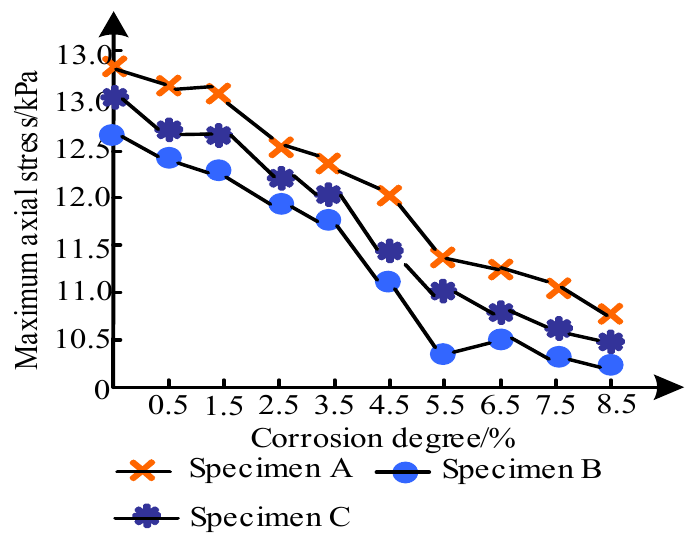
Figure 8. Maximum shear stress onanchor under different corrosion degrees.